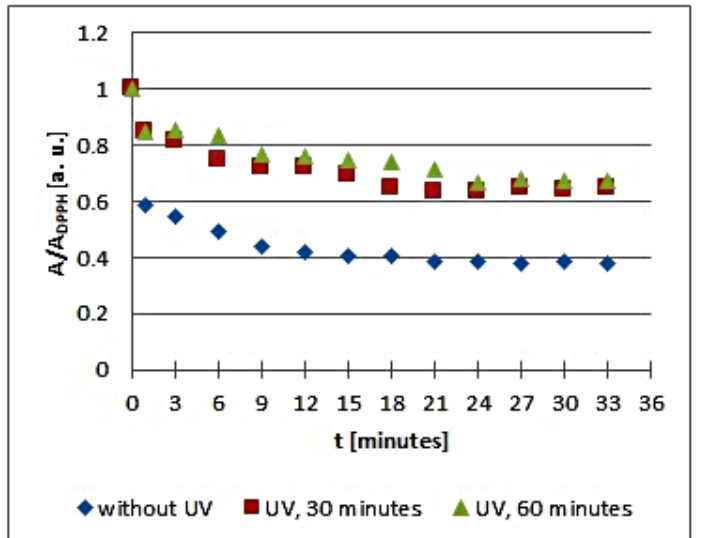
Figure 8. Changes of the relative amplitude (A/A DPPH ) of EPR spectra of DPPH free radicals with increasing time of interactions ( t ) with infusions of Galega officinalis L. herb. A—amplitude of the EPR line of DPPH free radicals in contact with the tested samples. A DPPH —amplitude of the EPR line of DPPH free radicals in the reference solution. For the reference solution, the relative amplitude (A/A DPPH ) takes a value of 1. Data for the infusions obtained from the plant materials exposed to UVA radiation for 30 and 60 min are presented. For comparison, data for the infusions of the plant material that was not exposed to UVA radiation are also given.